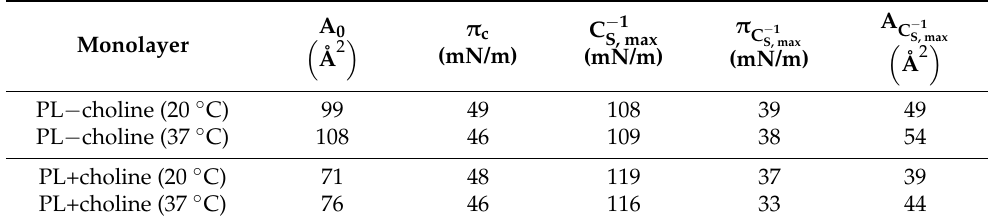
Table 3. Lift-o ff point ( A (cid:2868) ), collapse pressure ( π (cid:2913) ) and maximal ( C (cid:2929),(cid:2923)(cid:2911)(cid:2934)(cid:2879)(cid:2869) ) compression modulus along Table 3. Lift-off point (A 0 ), collapse pressure ( π c ) and maximal (C − 1 s,max ) compression modulus with the corresponding surface pressure and area per molecule ( π (cid:2887) (cid:3151),(cid:3171)(cid:3159)(cid:3182)(cid:3127)(cid:3117) , A (cid:2887) (cid:3177),(cid:3171)(cid:3159)(cid:3182)(cid:3127)(cid:3117) ) for the indicated along with the corresponding surface pressure and area per molecule ( π monolayers. indicated